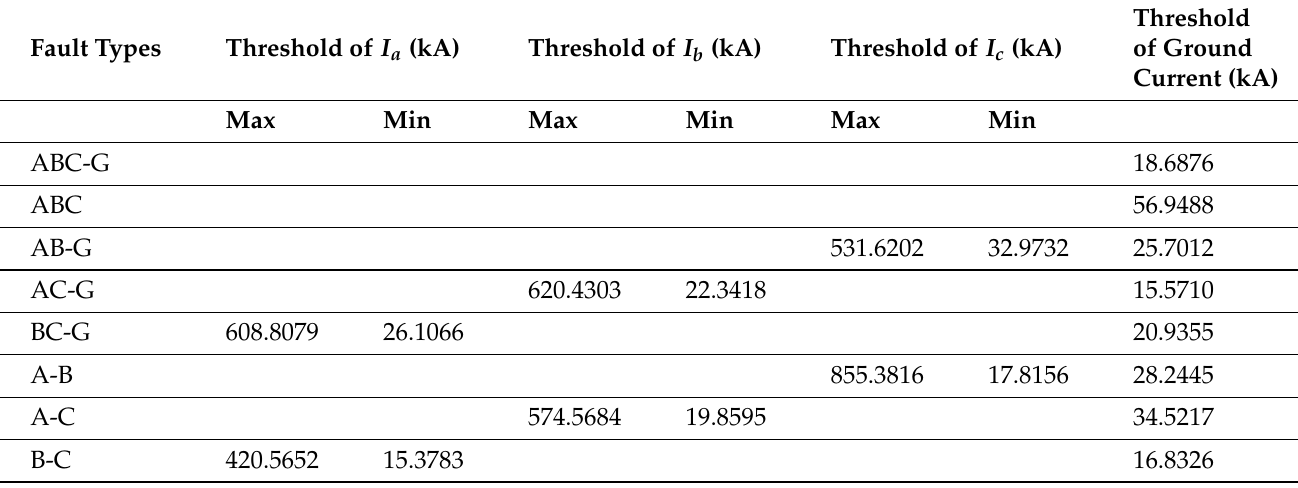
Table 2. Threshold value of current at different fault